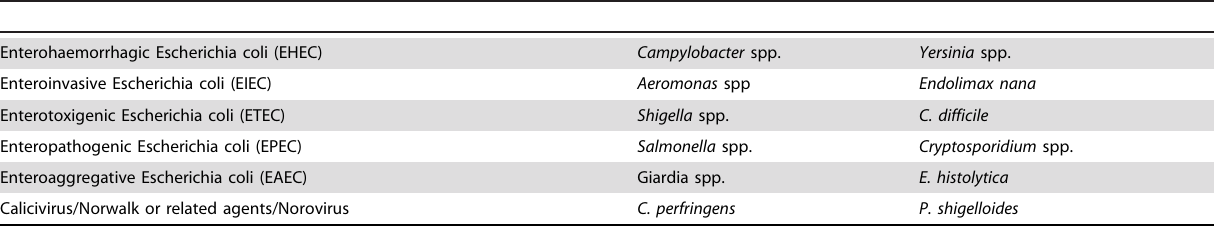
Table 1. Pathogens included in initial